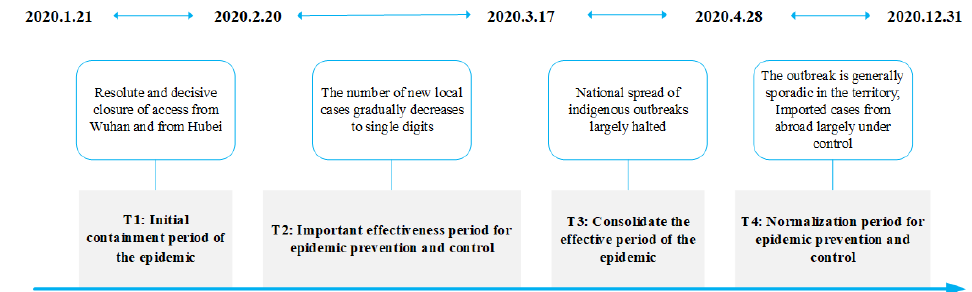
Figure 2. The main line of event development followed in the study of this paper.